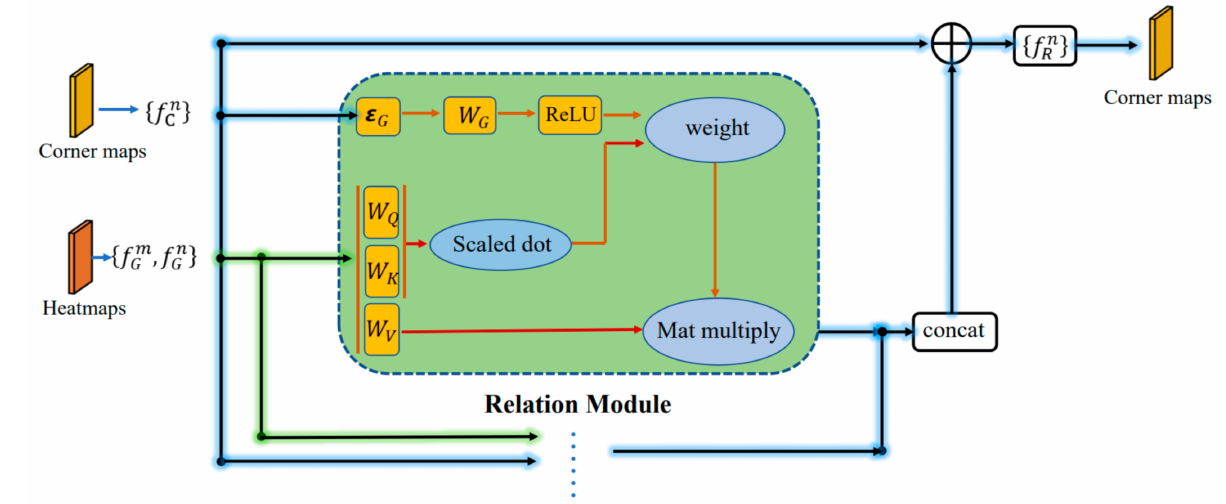
Figure 3. The architecture of the keypoint relation module